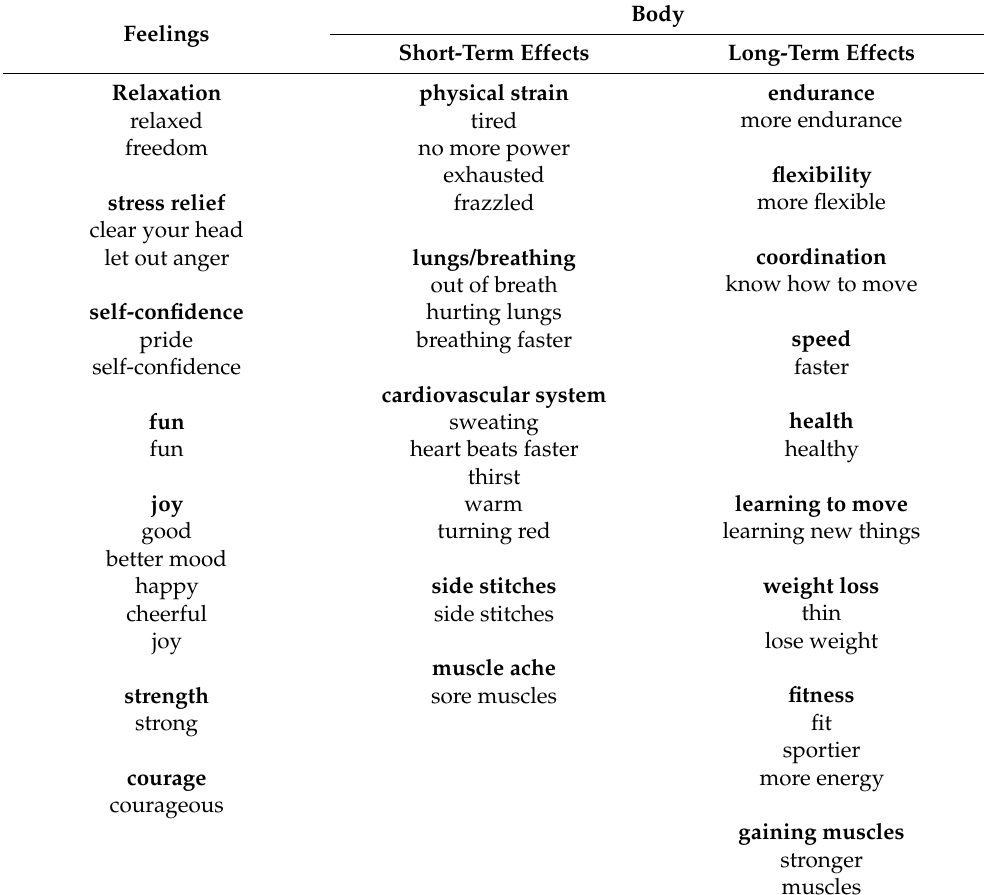
Table A2. Clusters of the subdomain knowledge and understanding (‘body, short- and long-term (time span)’ and ‘feelings’).